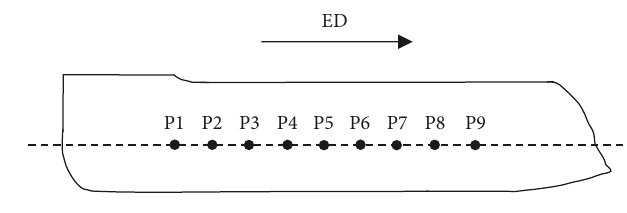
Figure 16: Distribution of observation points.